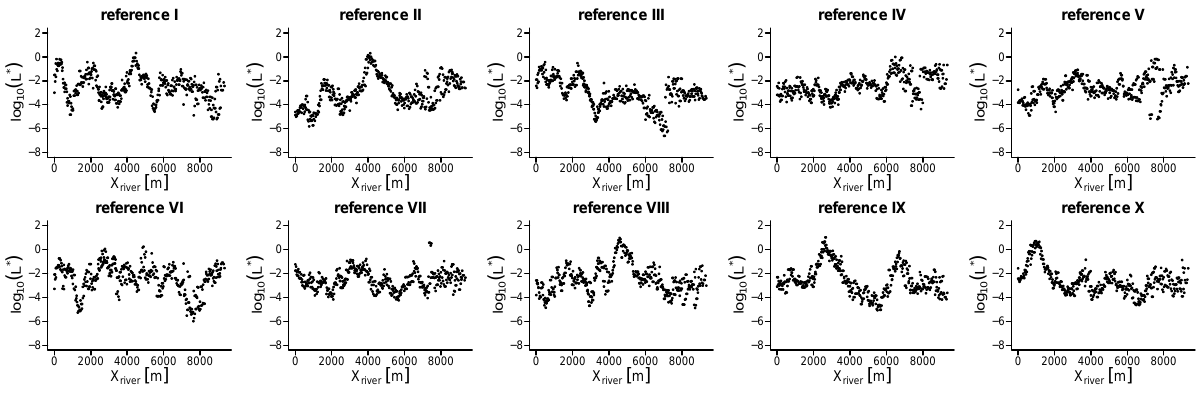
Fig. 2. Reference fields of leakage coefficients for scenario A along the river reach. Distance X river is calculated starting from the two most western river nodes. L ∗ has units ms − 1 .